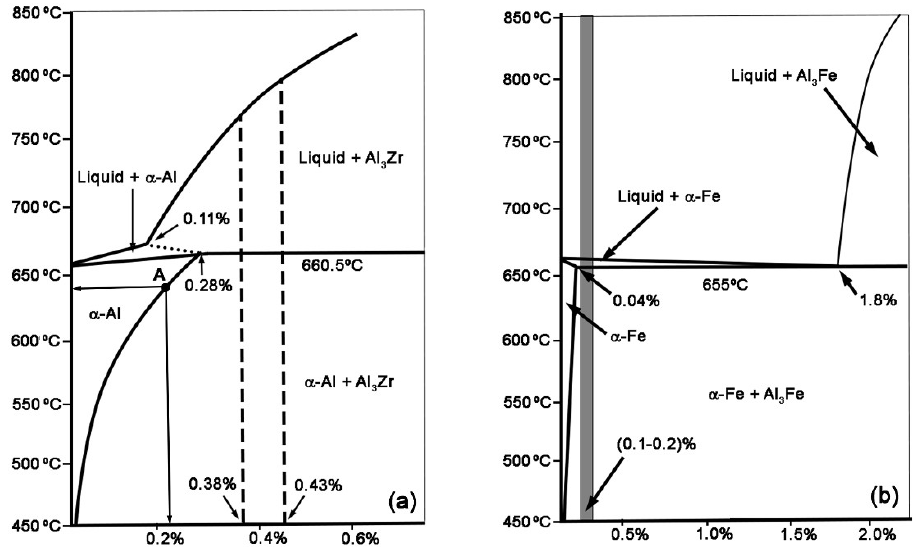
Figure 1. Al-Zr and Al-Fe equilibrium binary diagrams. Percentages by weight are shown on the abscissa axes. ( a ) Al-Zr diagram. Alloy-I has 0.38% Zr and Alloy-II 0.43%; ( b ) Al-Fe diagram. Both alloys are represented with the grey-shaded band.